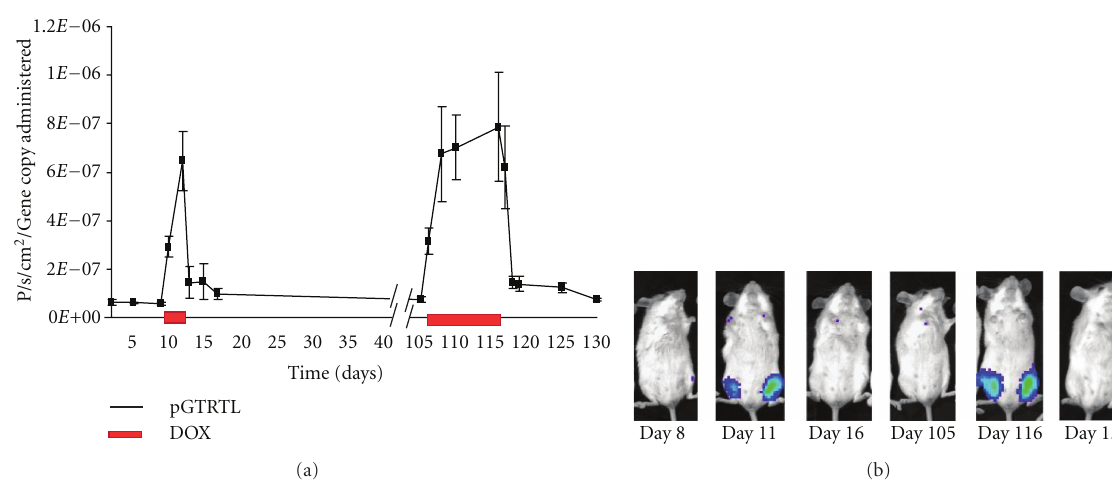
Figure 4: Long-term controllable transgene expression using doxycycline-inducible plasmid. pGTRTL was delivered to quadriceps muscle ( n = 22) by electroporation and luminescence analysed in vivo over time using IVIS live whole body imaging. Doxycycline was administered from days 8–11 and days 105–118 inclusively (red bar). E ffi cient, reproducible, high-magnitude expression was noted on induction with